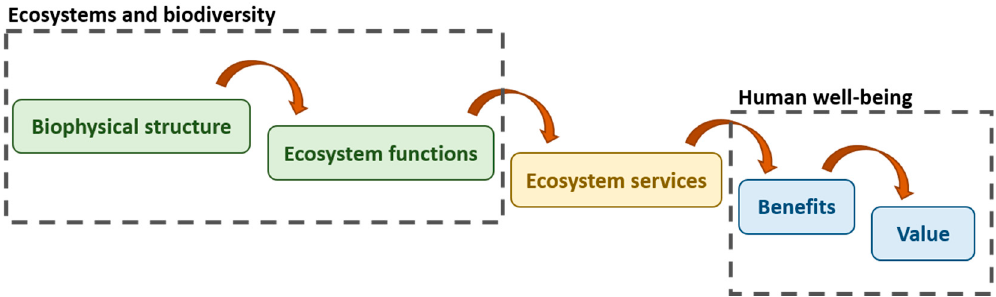
Figure A2. Relation between ecosystem functions, services, benefits, and value (adapted from [22]).